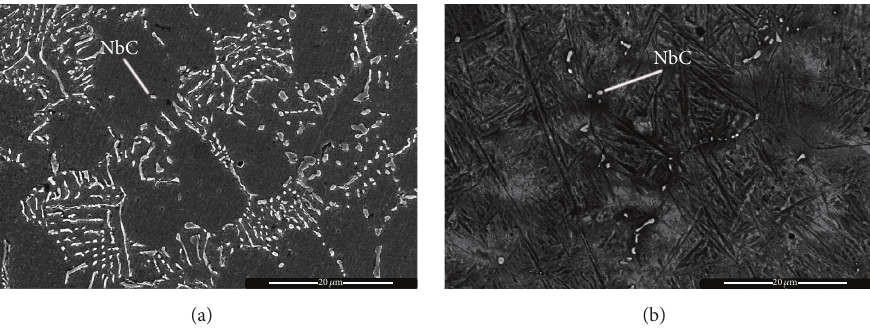
Figure 4: Carbides distribution: (a) alloy 2 and (b) alloy 8.